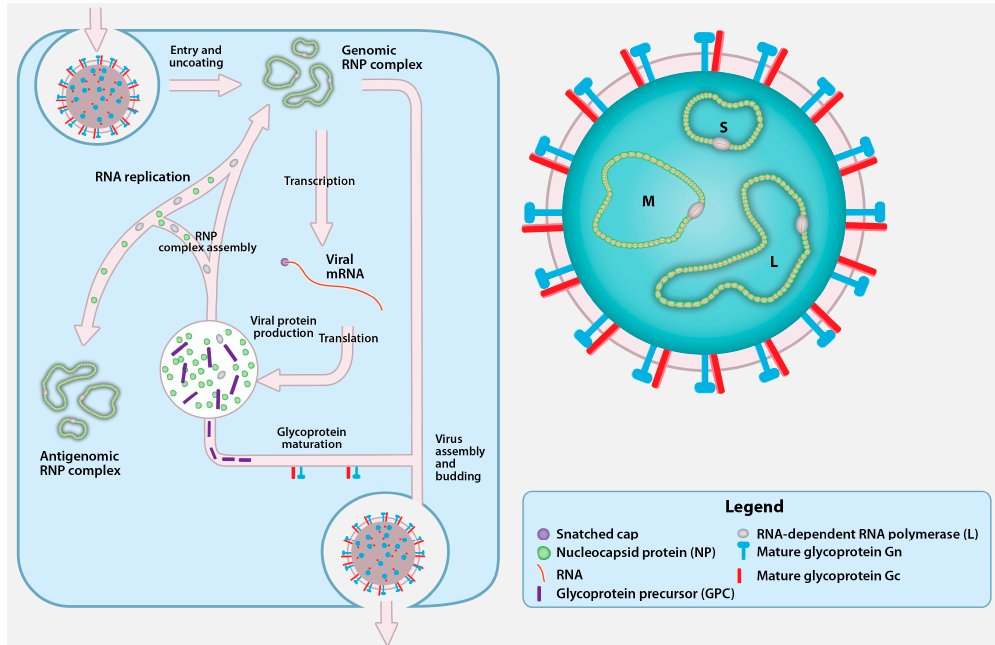
Figure 1. Crimean-Congo hemorrhagic fever virus (CCHFV) virion and replication cycle. The CCHFV virion contains a tri-segmented, negative-sense, single-stranded RNA (vRNA) genome encapsidated by the nucleoprotein (NP) and the RNA-dependent RNA polymerase (RdRp; L protein). Together, vRNA, NP, and RdRp form the genomic ribonucleoprotein complexes (RNP) inside a cellular membrane-derived envelope coated with the mature glycoproteins Gn and Gc. CCHFV attaches to an unidentified cellular receptor and enters the cells in a clathrin-dependent manner. After fusion with